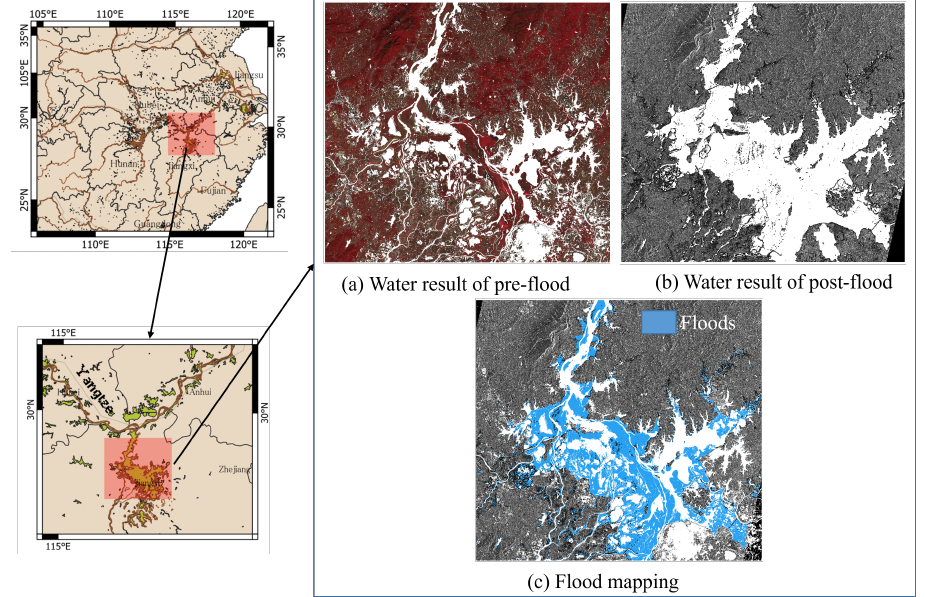
Figure 14. Flood mapping based on the pre-flood GF-1 multispectral and post-flood GF-3 SAR